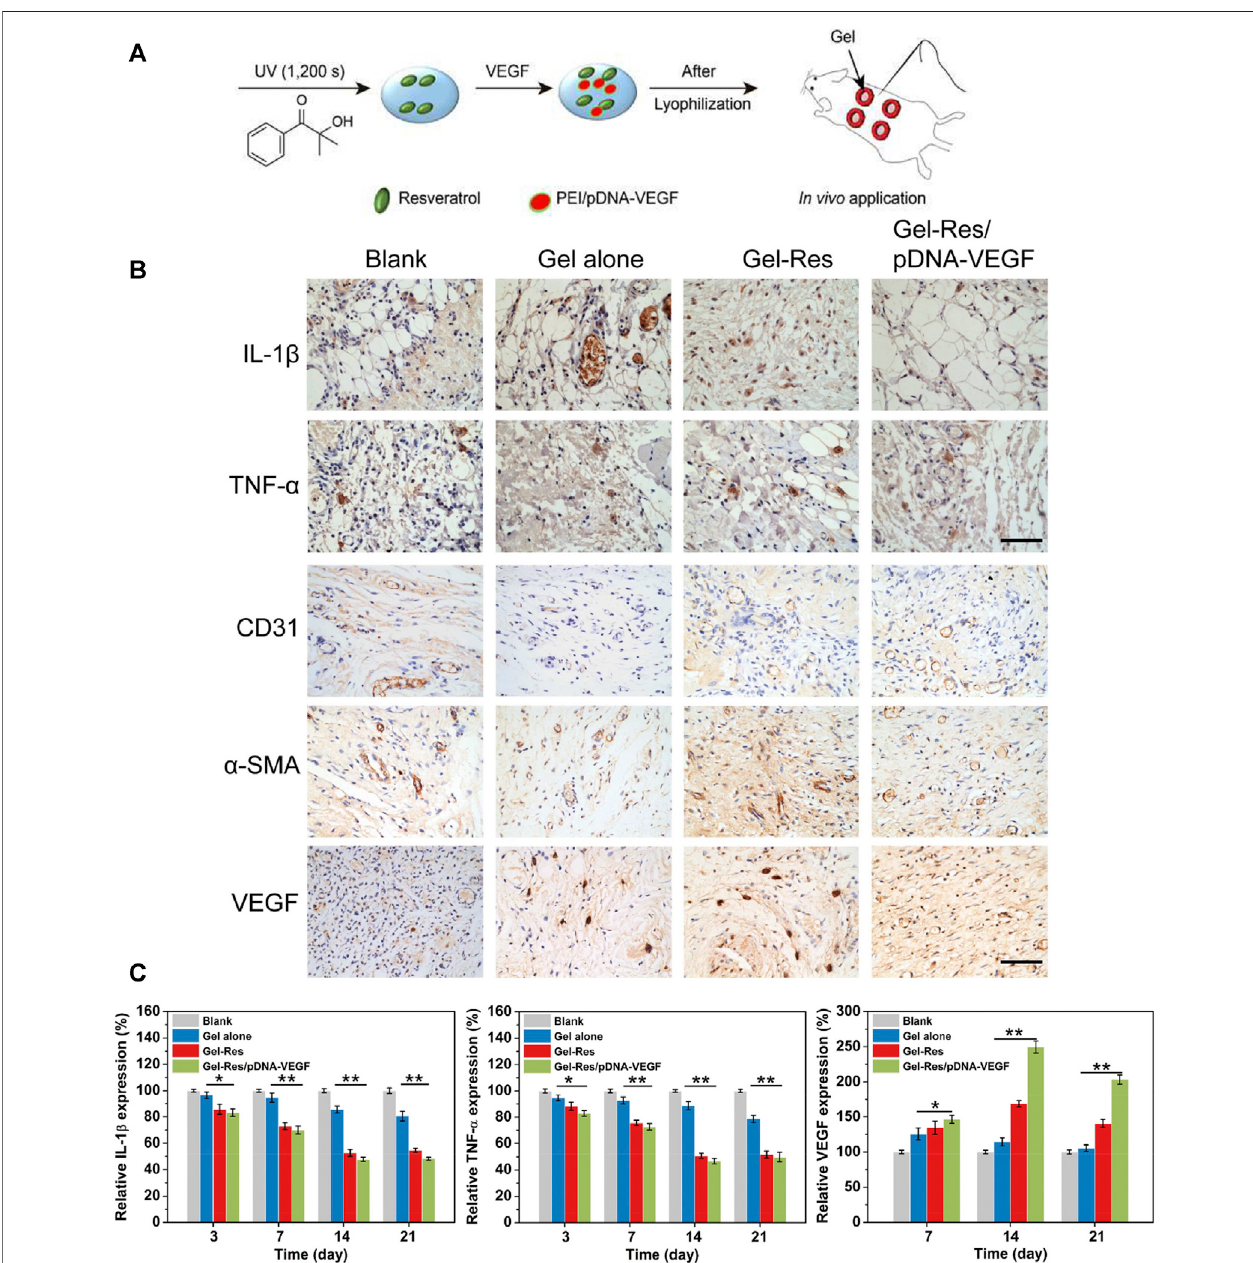
FIGURE 7 | In situ -formed anti-in fl ammatory hydrogel loaded with plasmid DNA encoding VEGF for healing of burn wounds. (A) Application of this hydrogel in a model of a splinted excisional wound (schematic). (B) Immunohistochemical staining showing expression of the proin fl ammatory cytokines IL-1 β and TNF- α . (C) Immunohistochemical staining showing expressions of the angiogenic factors VEGF, CD31, and α -SMA. Scale bar (cid:1) 100 μ m. (D) RT-qPCR of mRNA expression for in fl ammatory and angiogenic factors (IL-1 β , TNF- α , VEGF). ** p ≤ 0.01, * p ≤ 0.05. Reproduced with permission from (Wang et al., 2019).